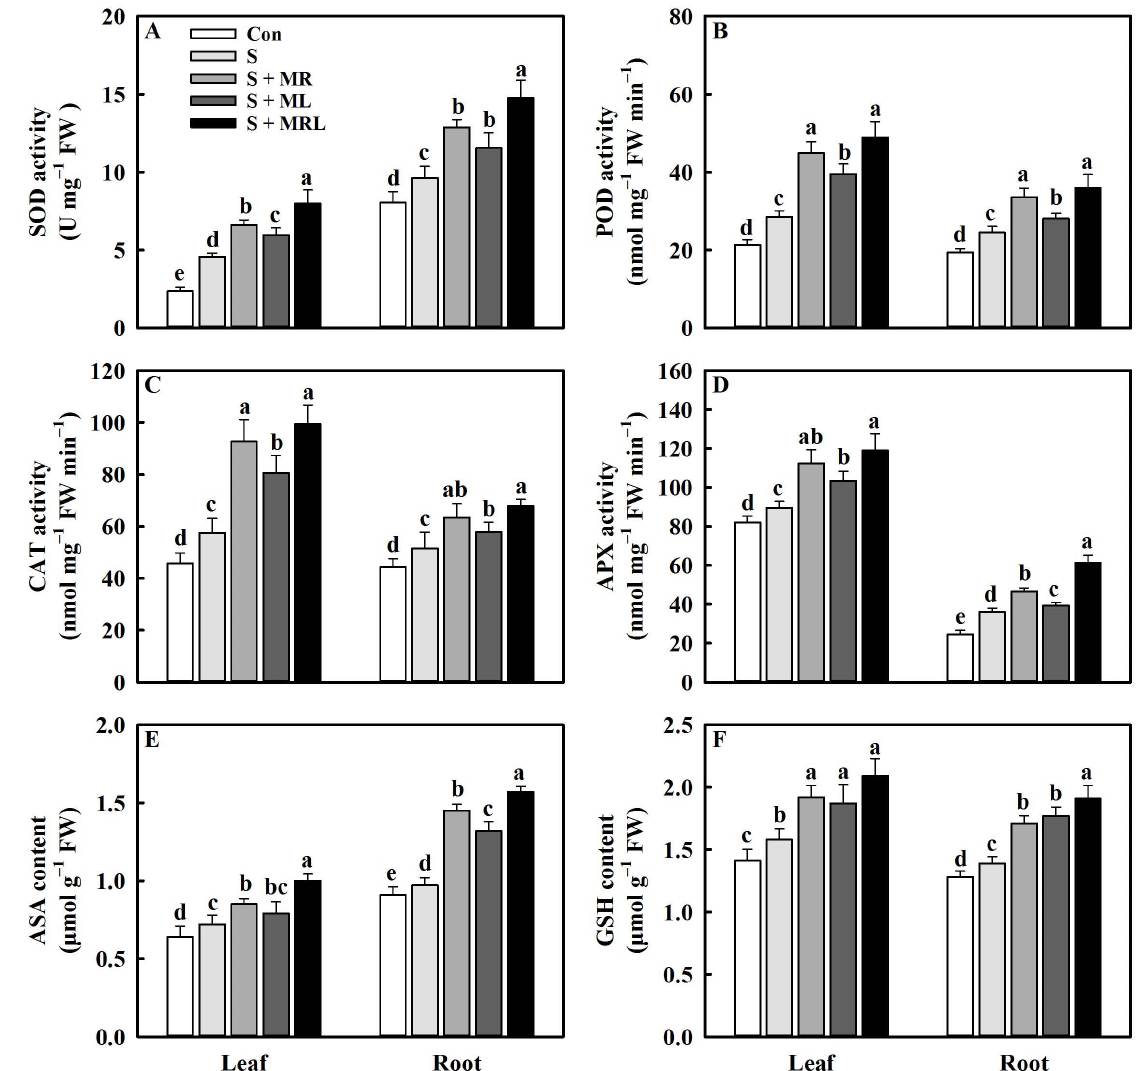
Figure 6. Effect of different methods of melatonin application on antioxidant enzyme activities and antioxidant contents of sugar beet seedlings under salt stress. ( A ) Superoxide dismutase (SOD) activity, ( B ) peroxidase (POD) activity, ( C ) catalase (CAT) activity, ( D ) ascorbate peroxidase (APX) activity, ( E ) ascorbic acid (ASA) content, and ( F ) glutathione (GSH) content in leaves and roots. Con, control treatment; S, salt stress treatment; S + MR, salt stress treatment + root application of melatonin; S + ML, salt stress treatment + foliar application of melatonin; S + MRL, salt stress treatment + combined root and foliar applications of melatonin. Data show the means ± standard errors ( n = 4). Different letters indicate significant differences between treatments according to Duncan’s multiple range test ( p <